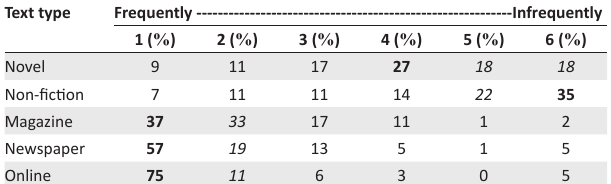
FIGURE 3: Self-reported frequency of reading for TABLE 1: Frequency in relation to text type.